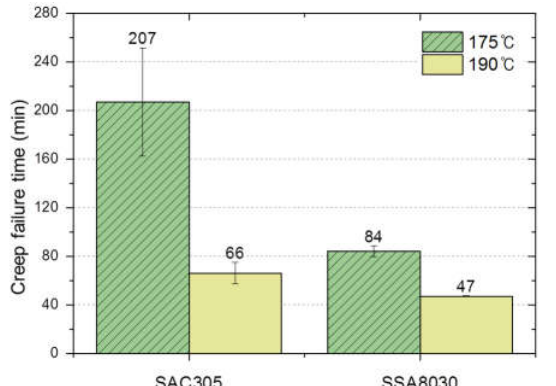
Figure 4. Effects of solders and test temperature on creep failure time. The bars correspond to standard deviations.